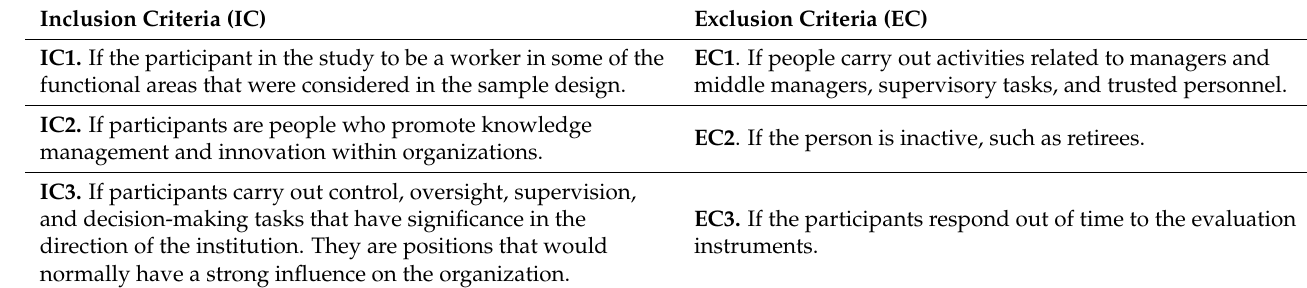
Table 2. Inclusion and exclusion